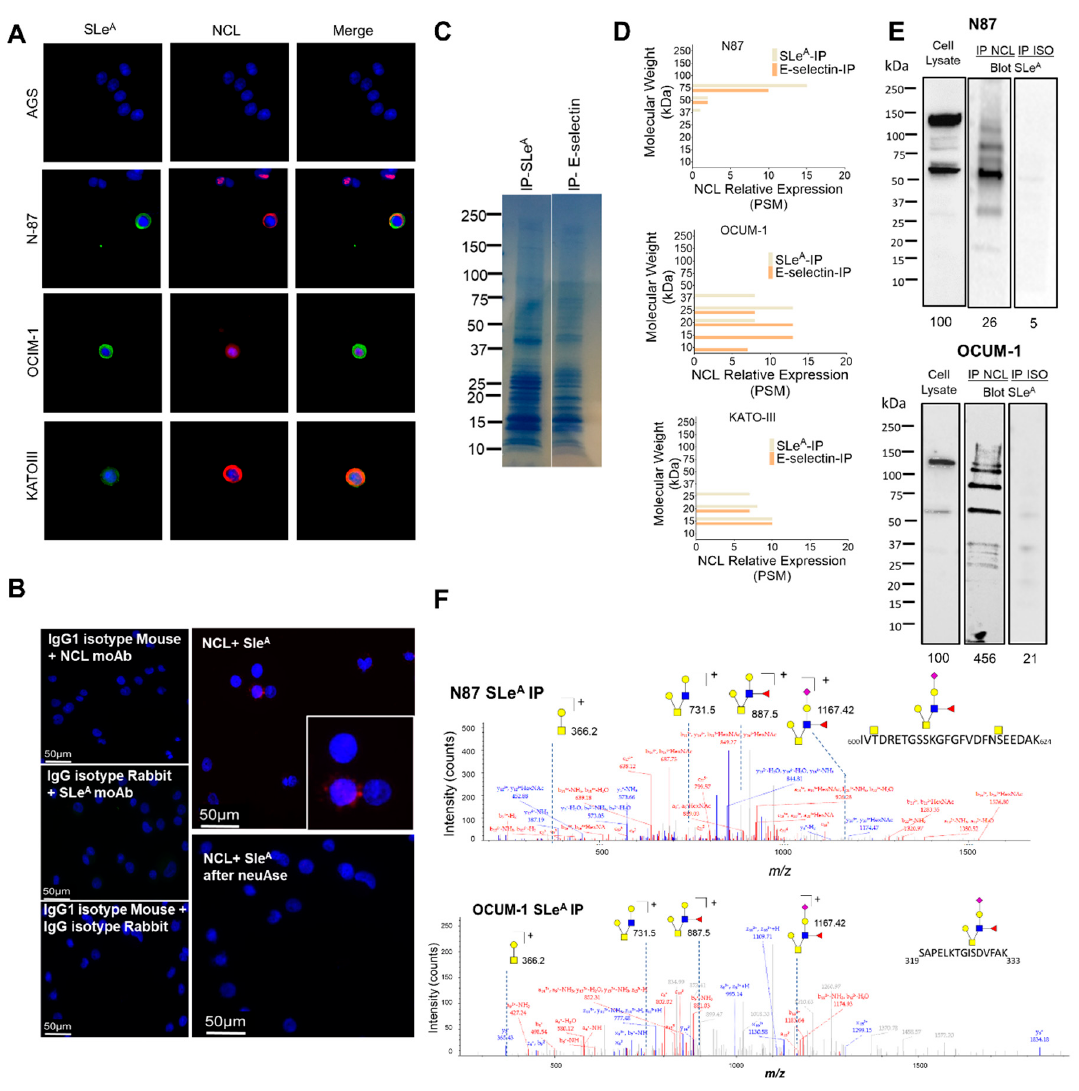
Figure 5. Identification of NCL-SLeA glycoforms in GC cell models. ( A ) Immunofluorescence staining of GC cells (AGS, N87, OCUM-1, KATO-III) for SLeA (green) and NCL (red). Neither SLeA nor NCL were detected in AGS cell lines. However, clear cell membrane staining was observed for both antigens in N87, OCUM-1 and KATO-III. ( B ) Proximity ligation assays for NCL-SLeA in N87 cells. Positive PLA signals (white arrows) were observed in N87 cells, which significantly decreased upon PNGase F treatment and completely disappeared in cells treated with neuraminidase. ( C ) Typical SDS-PAGE for glycoproteins isolated by IP for SLeA and E-selectin. The gels were an important starting point for molecular weight resolved identification of NCL in GC cells. ( D ) NCL expression according to molecular weight resolved glycoproteomics analysis. NCL appears between 50 and 100 kDa, with a major band just above 50 kDa. Notably, shorter proteoforms (37–15 kDa) can also be observed in OCUM-1 and KATO-III cell lines. IP-SLeA and IP-E-selectin showed similar NCL patterns. ( E ) MS / MS for NCL-SLeA glycopeptides identified by Mw-resolved glycoproteomics in N87 and OCUM-1 cell lines. Tandem mass spectra support the existence of glycopeptide fragments carrying the SLeA antigen between 50 and 75 kDa for the N87 cell line and between 25 and 37 kDa for OCUM-1 cells. ( F ) Western blots for NCL in whole cell lysates and in SLeA expressing glycoproteins isolated by immunoprecipitation (IP) for N87 and OCUM-1 cells. Neuraminidase digested samples prior to IP were used as negative controls. The blots show that SLeA IP were enriched for shorter NCL proteoforms in comparison to the whole cell extract, with emphasis on bands between 50 and 75 kDa. Bands bellow 50 kDa could also be observed in both cell lines, reinforcing MS analysis data showing low molecular weight NCL-SLeA glycoforms. SLeA IPs performed after neuraminidase digestion did not show positive NCL signals, supporting the specificity of